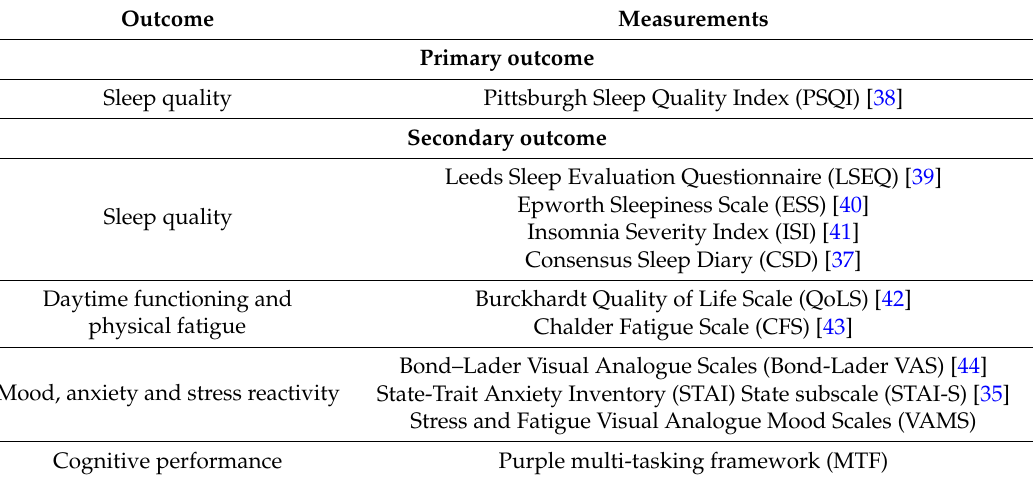
Table 2. Outcome